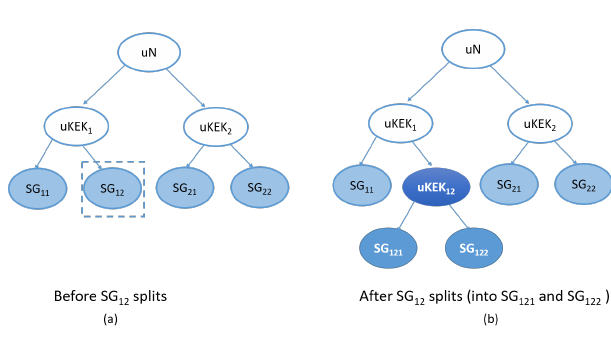
Figure 7. The figure on the left (respectively, right) shows the outer LKH tree before (respectively, after) SG 12 splits into two SGs– SG 121 and SG 122 . The group key of SG 12 becomes the uKEK, uKEK 12 , for the users in the two